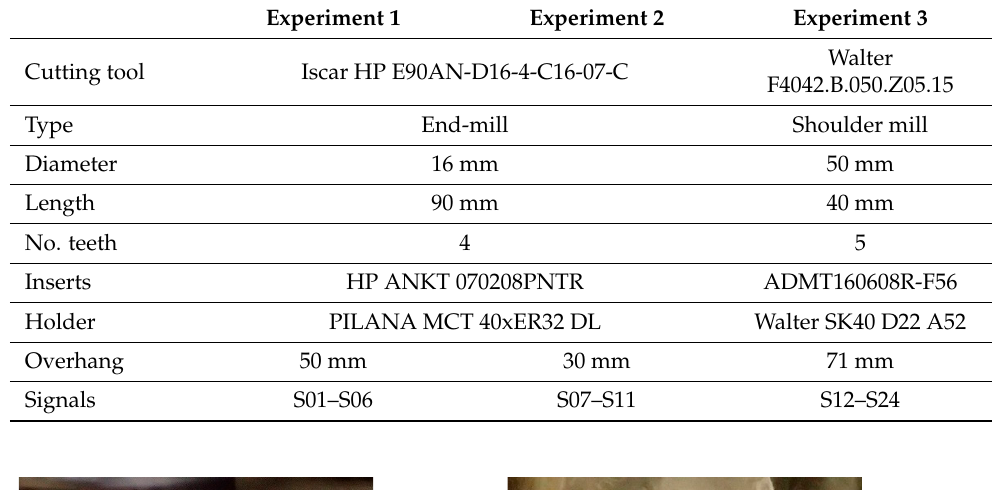
Table 1. Summary of performed experiments.